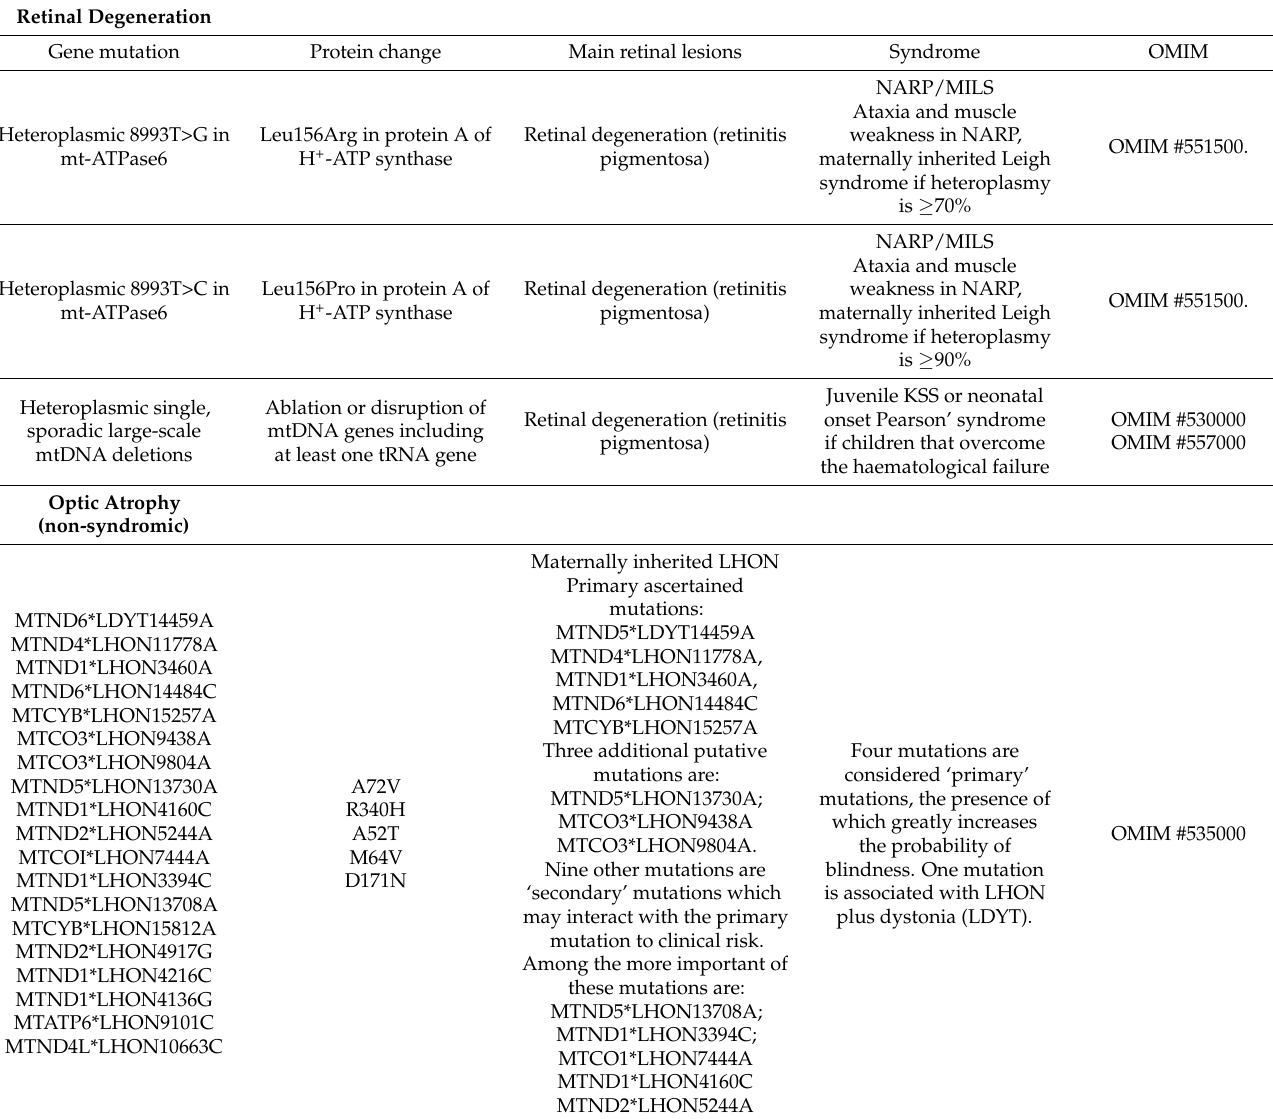
Table 1. Genes involved in mitochondrial